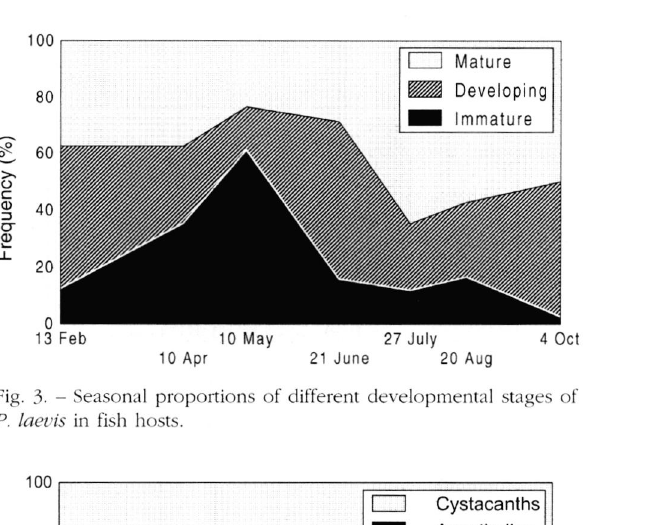
Fig. 3- - Seasonal proportions of different developmental stages of P. laevis in fish hosts.